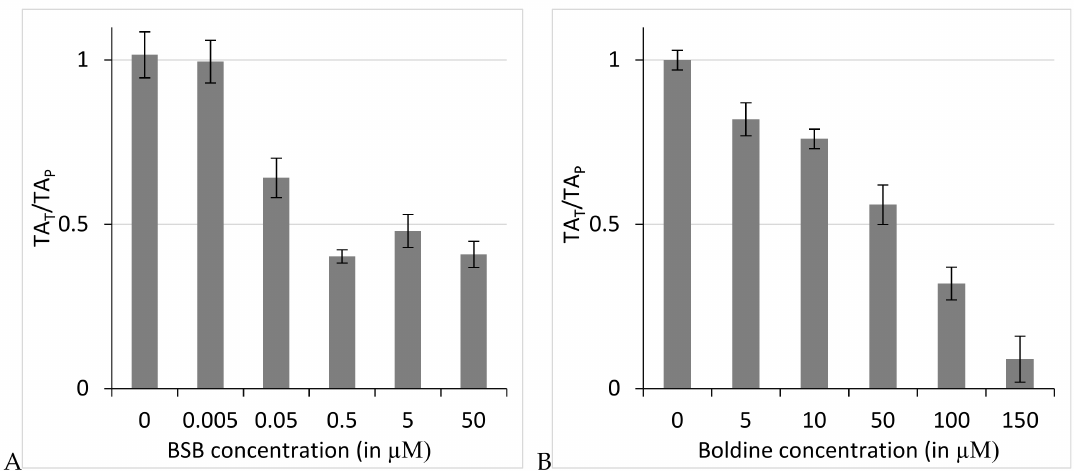
Figure 2. Relative telomerase activity of q-TRAP-ligand reactions when treated with N -benzylsecoboldine (BSB) ( A ) or boldine ( B ) before telomere elongation to q-TRAP-ligand reactions when treated after telomere elongation. The mean value ± SEM is